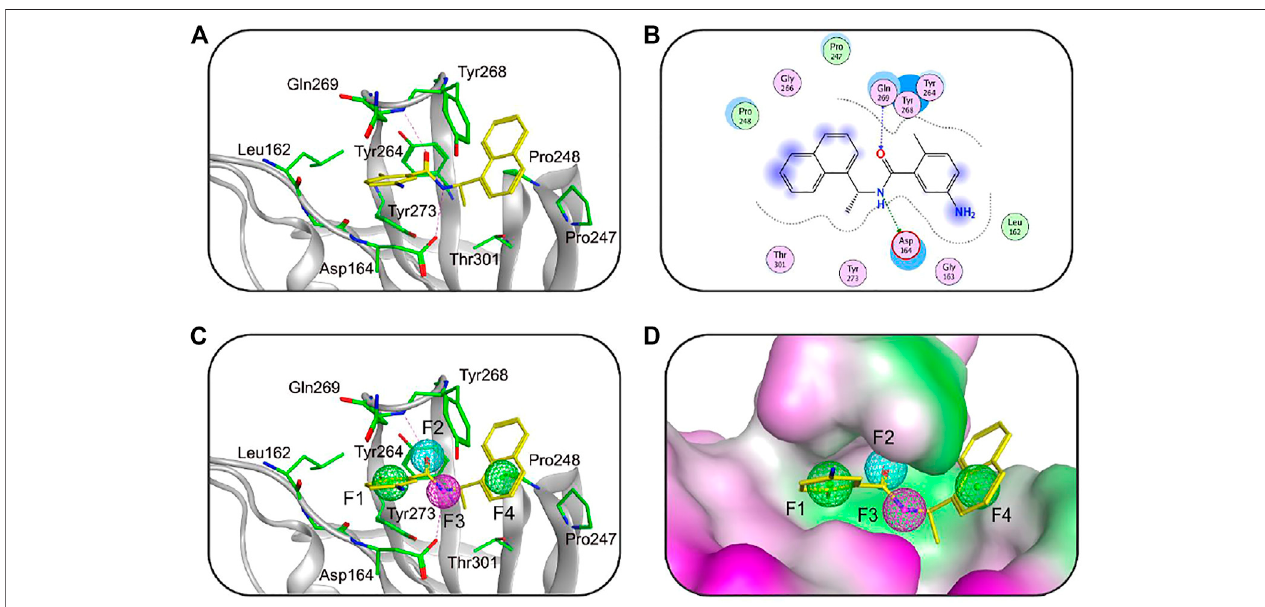
FIGURE 1 | (A) The three-dimensional (3D) interaction diagram of the binding site of SARS-CoV-2 PLpro (PDB ID: 7CMD) with GRL0617. The active-site residues andGRL0617areshowninstickform.Thehydrogen-bondnetworkwithresiduesisindicatedbyreddottedlines. (B) 2DinteractiondiagramofthebindingsiteofSARS- CoV-2 PLpro with GRL0617. (C) The generated 3D pharmacophore model at the active site of PLpro. (D) Closeup stereo view of the pharmacophore model. Pharmacophore features are color-coded: green, two aromatic features (F1 and F4); cyan, one hydrogen-bond acceptor feature (F2); purple, one hydrogen-bond donor feature